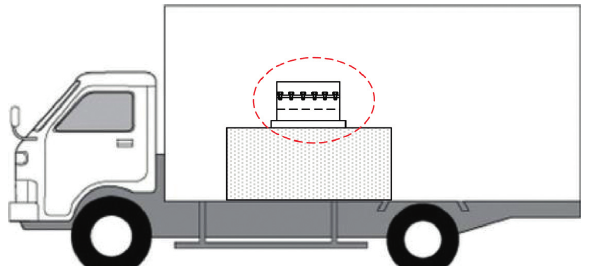
Figure 1: A clamping support structure used to fix cargo during transportation.